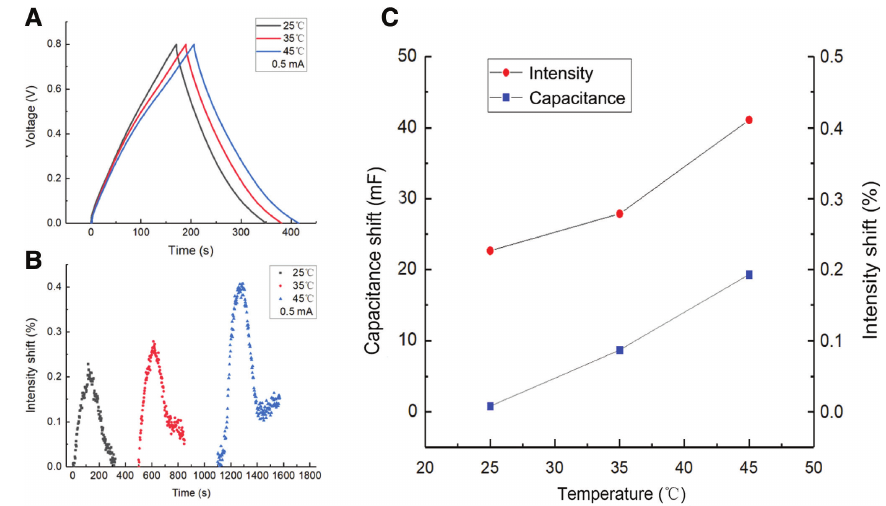
Figure 7: Charge and discharge tests of supercapacitor at different working temperature. (A) Galvanostatic charge-discharge curve at different temperature (0.5 mA). (B) Real-time intensity shift of fiber-optic LSPR sensors at different temperature in galvanostatic test (0.5 mA). (C) The capacitance shift calculated by galvanostatic curve and LSPR intensity shift in different temperature (25 ° C, 35 ° C, 45 °